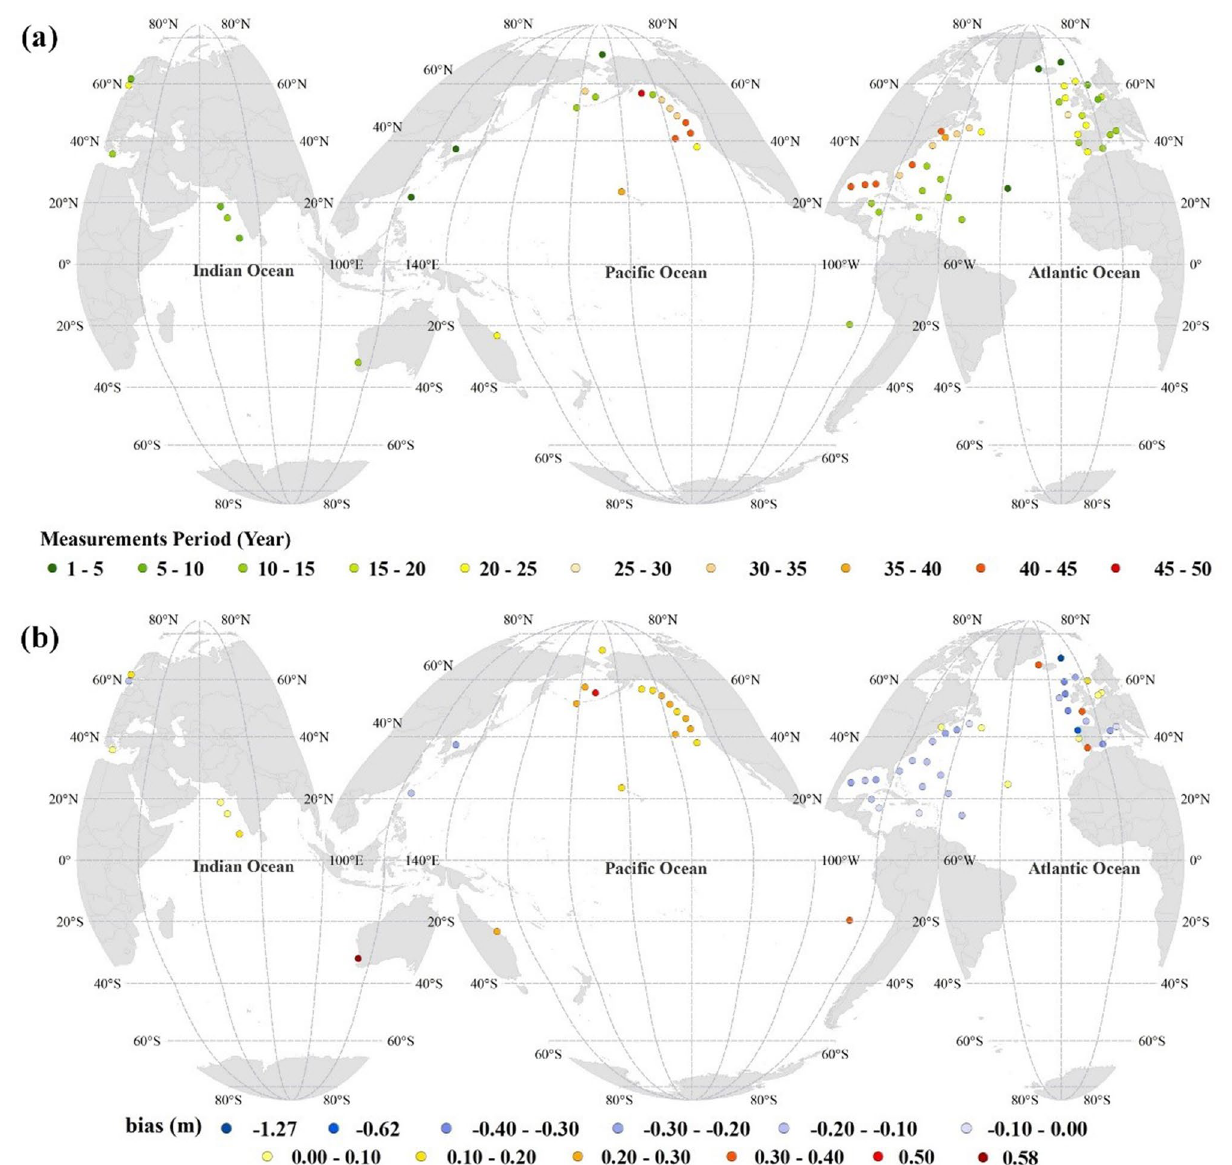
Figure 7. Map of ( a ) wave measurement period at each buoy location and ( b ) the bias in for H s . The figure has been generated using ArcGIS 10.2 and Natural Earth-Free vector and raster map data @ naturalearthdata.com.